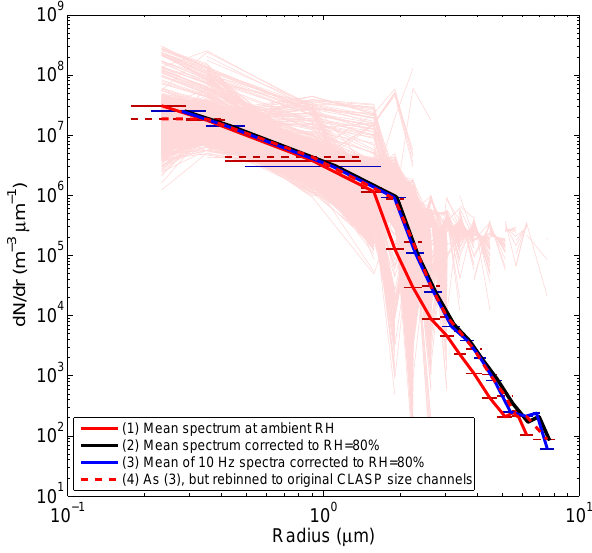
Fig. 1. An example of using the high-rate relative humidity correc- tion technique described here. The pale red lines show the 12000 in- dividual spectra which were measured at 10Hz by the CLASP unit. The solid red line show the mean of these spectra at the mean am- bient relative humidity. The black line shows the mean spectra cor- rected from the mean relative humidity (60%) to a reference humid- ity of 80%. The blue line shows the mean of the 12000 individual spectra after each has been adjusted to 80% relative humidity (note that this spectrum is then defined over the mean channel boundaries of these individual adjusted spectra). The dashed red line shows the mean of the 12000 spectra once they have been both adjusted to 80% and re-binned back to the original CLASP channel